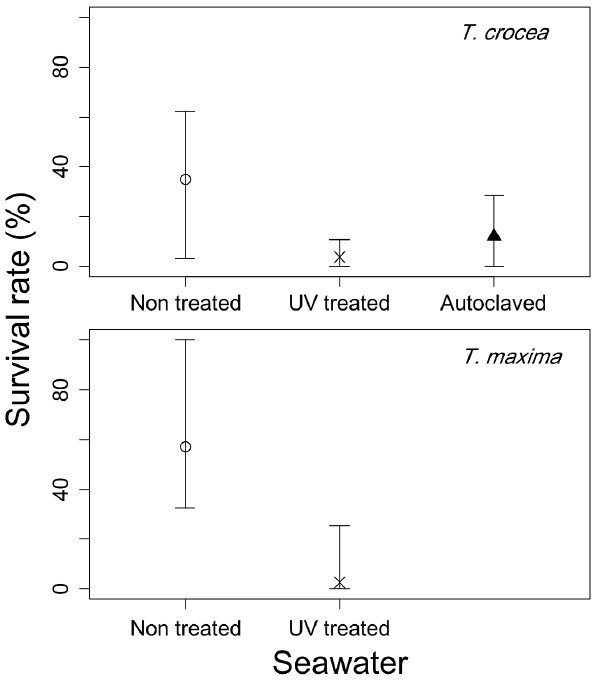
Figure 4. Survival rates of Tridacna crocea (Run 1) and Tridacna maxima (Run 2) in the monoculture experiments. Showing the mean (circle, cross, triangle) and range (vertical line) of survival rates of the seeds reared in non treated, UV treated and autoclaved seawater with no addition of Symbiodinium. For Run 2, autoclaved seawater was not tested.